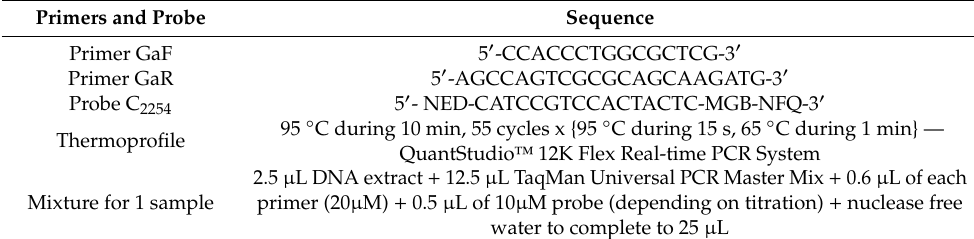
Table 2. PCR conditions of the newly developed assay (PCR 3) for C 2254 strain detection. Primers and